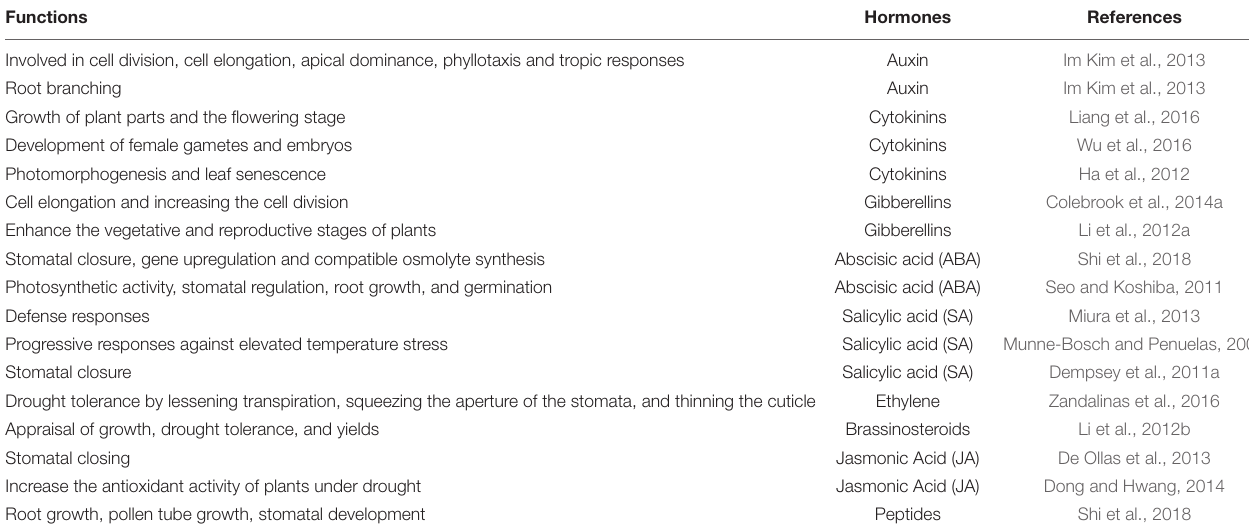
TABLE 2 | Phytohormones functions to prevent plants from drought stress.